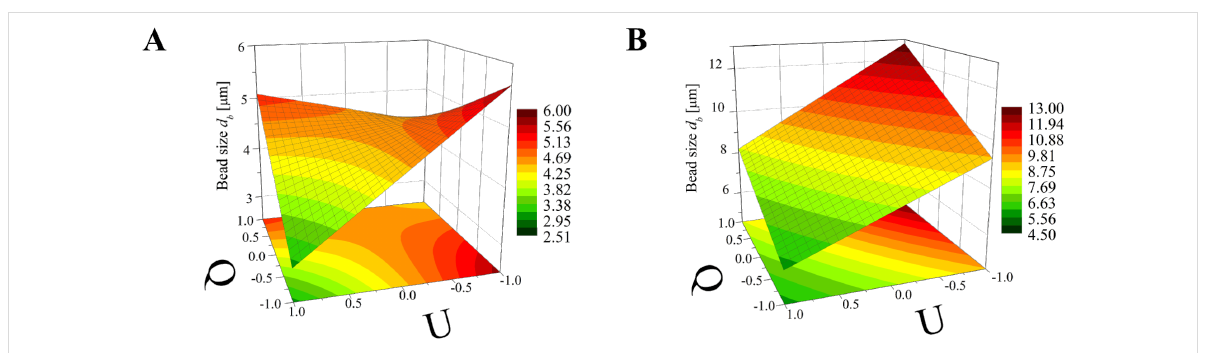
Figure 12: Response surface plots presenting the dependence of the size of obtained beads ( d b ) on the electrical voltage ( U ) and the flow rate ( Q ) of the polymer solution for (A) minimum dynamic viscosity (µ = − 1) and (B) maximum dynamic viscosity (µ = +1) .